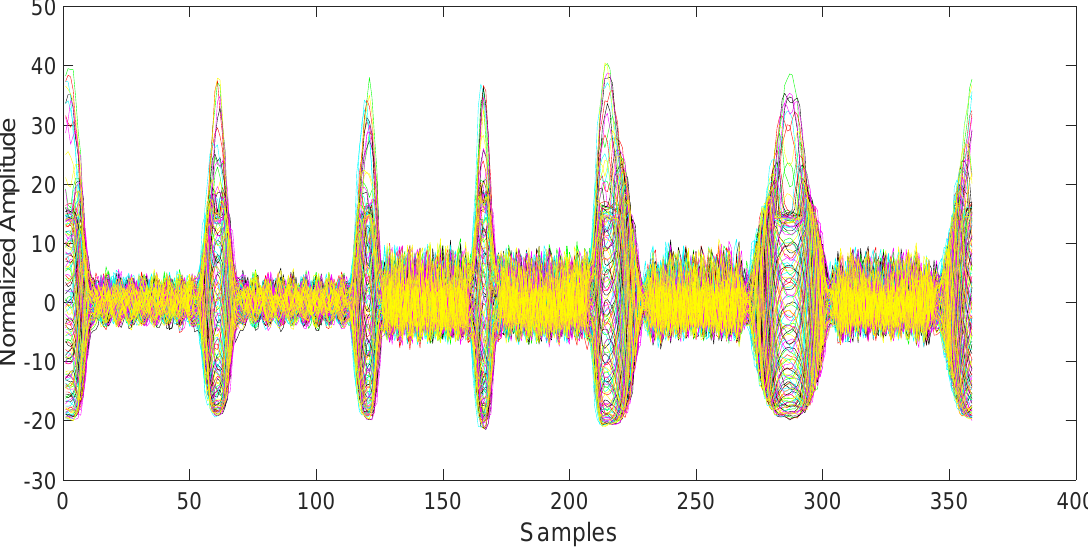
Figure 3. Magnetometers output for all 6 days of data collection after synchronization and normalization. Each color represents a different day.